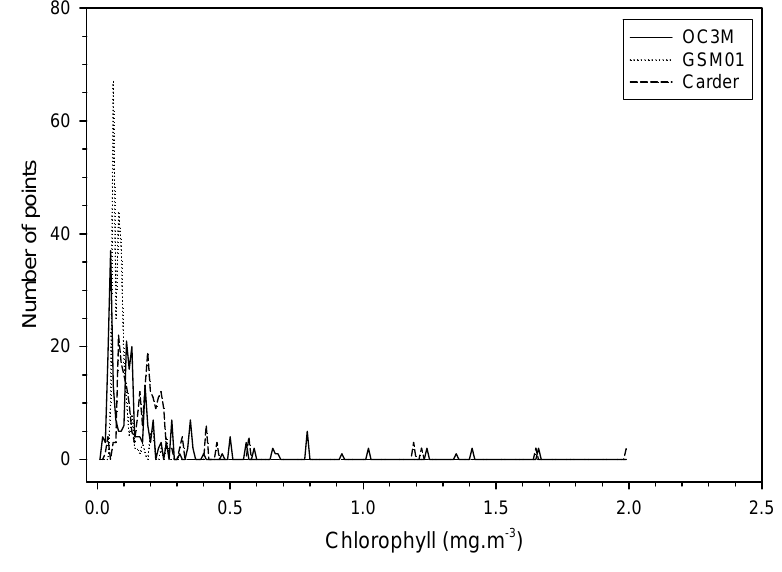
Figure 4. Histograms of MODIS chlorophyll concentration estimates obtained with OC3M, GSM01, and Carder algorithms for the in situ sampled area on 11/25/2004 (see text for details).